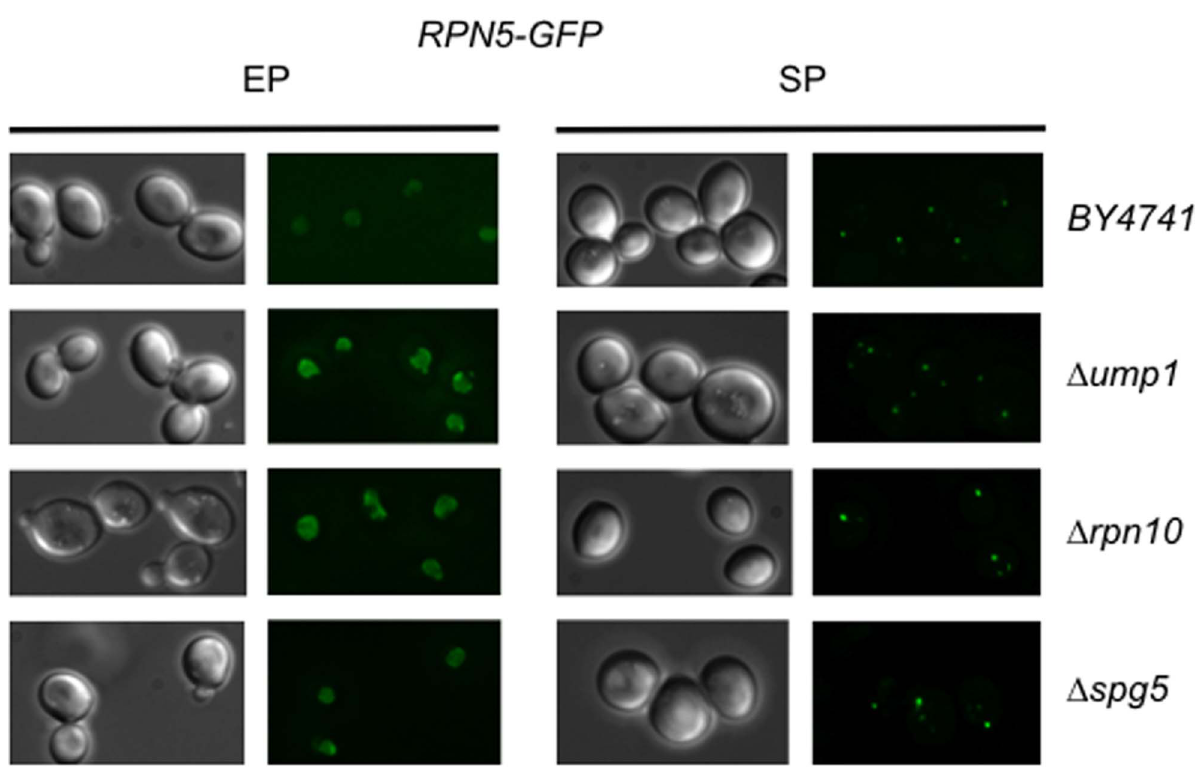
Figure 3. Rpn5-GFP localization in proteasome assembly defect mutant cells in exponential and stationary growth phases. Wild type, D ump1 , D rpn10 and D spg5 cells expressing Rpn5-GFP were grown in glucose containing rich medium (YPD) at 26 u C and examined by fluorescence microscopy in the exponential growth phase (EP) and after 5 days in stationary phase (SP). Typical images of Rpn5-GFP localization are shown.